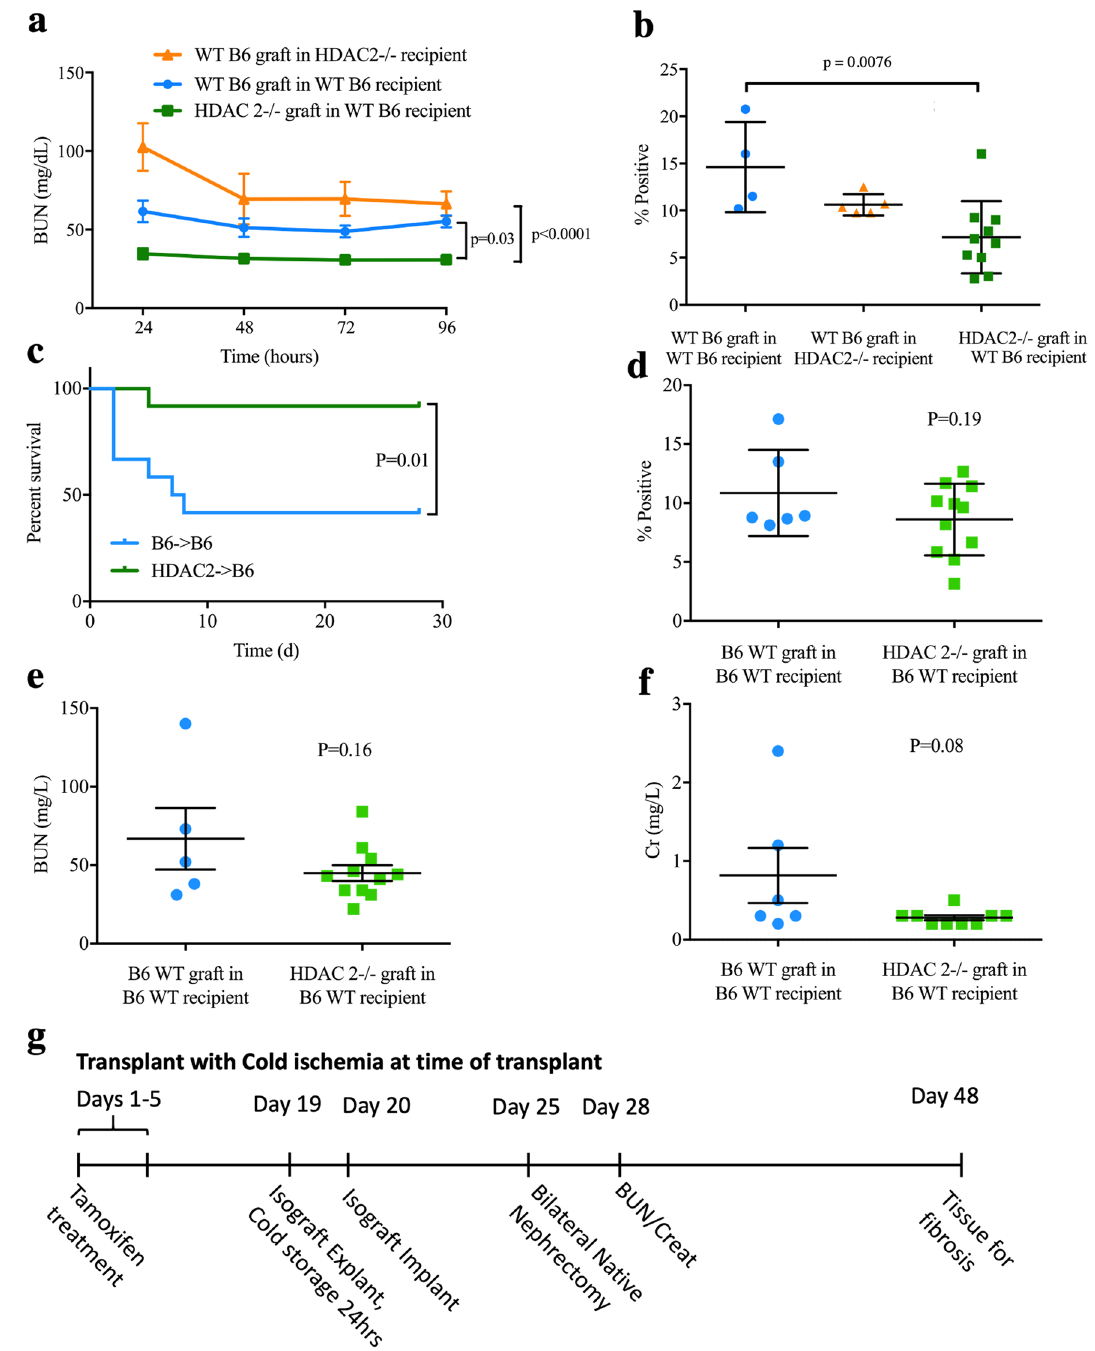
Figure 3. ( a ) BUN and ( b ) computerized scoring of renal fibrosis (Sirius Red stain) at 28 days in HDAC2- /- renal isografts in WT recipients (n = 10), WT B6 renal isografts in HDAC2-/- recipients (n = 5), and WT B6 renal isografts in WT recipients (n = 5). Data are expressed as mean ± SEM for ( a ) and mean ± SD for ( b ); significance was determined with 2-way ANOVA with Tukey’s post hoc test for ( a ), and with 1-way ANOVA with Tukey’s post hoc test for ( b ). ( c ) Survival after transplantation of HDAC2-/- or WT B6 renal isografts into a WT B6 recipient with 24-h cold ischemic times and bilateral native nephrectomy 5 days post-transplant; significance was determined by log-rank test (n = 12 mice/group at start). ( d ) Renal fibrosis with Sirius Red staining at 28 days among survivors; significance was determined using the unpaired t-test (n = 6 B6 WT in B6 WT and 11 HDAC2-/- in B6 WT). ( e ) BUN and ( f ) Cr at 8 days post-nephrectomy. ( g ) Experimental timeline for renal transplant with cold ischemia